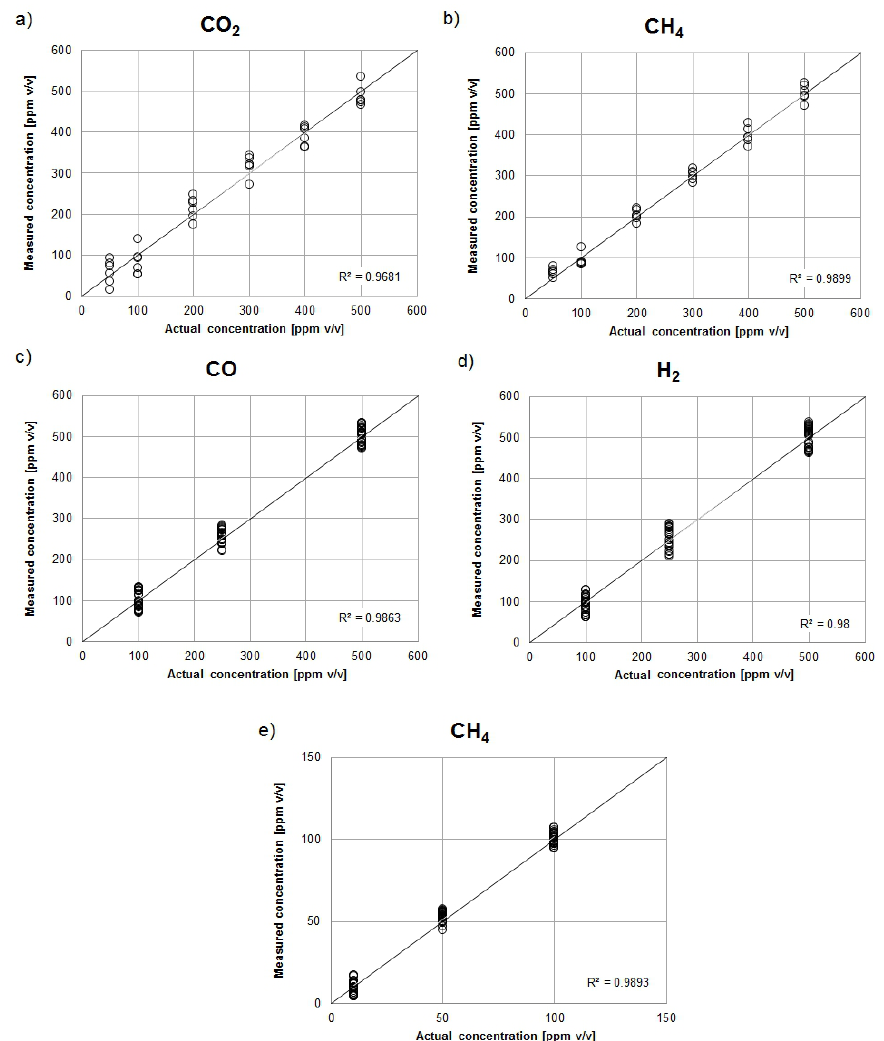
Figure 5. Validation plots of PCR calibration models for DRM inlet stream: ( a ) carbon dioxide, ( b ) methane and DRM outlet stream: ( c ) carbon monoxide, ( d ) hydrogen, ( e )